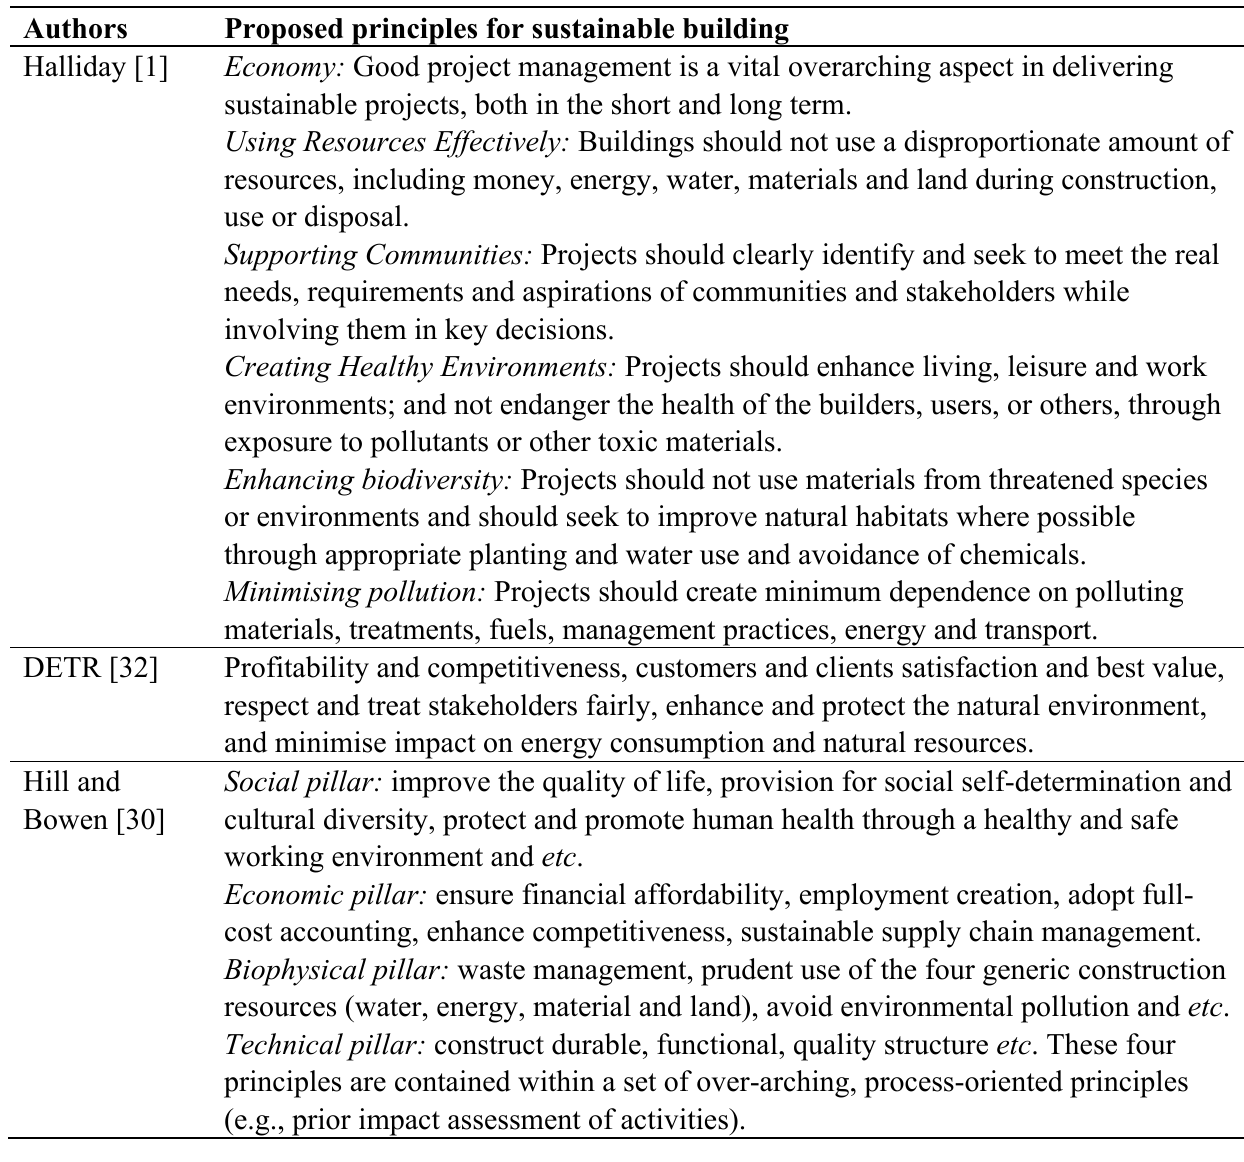
Table 2. Principles of sustainable